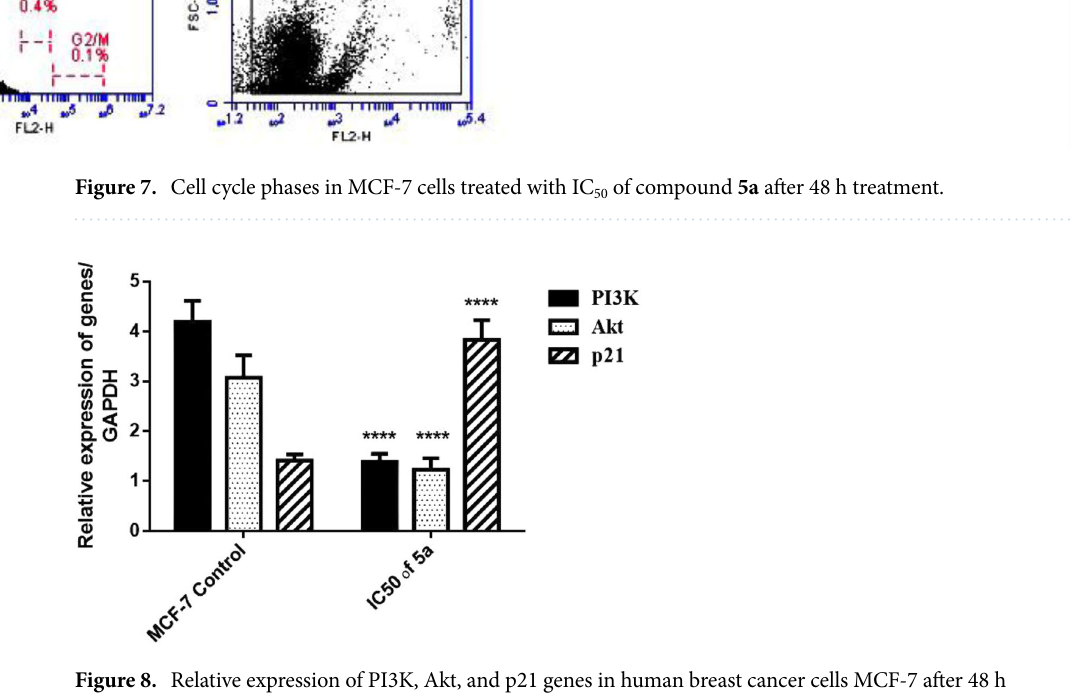
Figure 8. Relative expression of PI3K, Akt, and p21 genes in human breast cancer cells MCF-7 after 48 h treatment. IC 50 dose of 5a treatment downregulated PI3K and Akt while upregulated p21 gene expression in MCF-7 cells. Results are expressed as mean ± SE, (n = 3). p < 0.05 is considered significant, where *: significantly different from the MCF-7 control